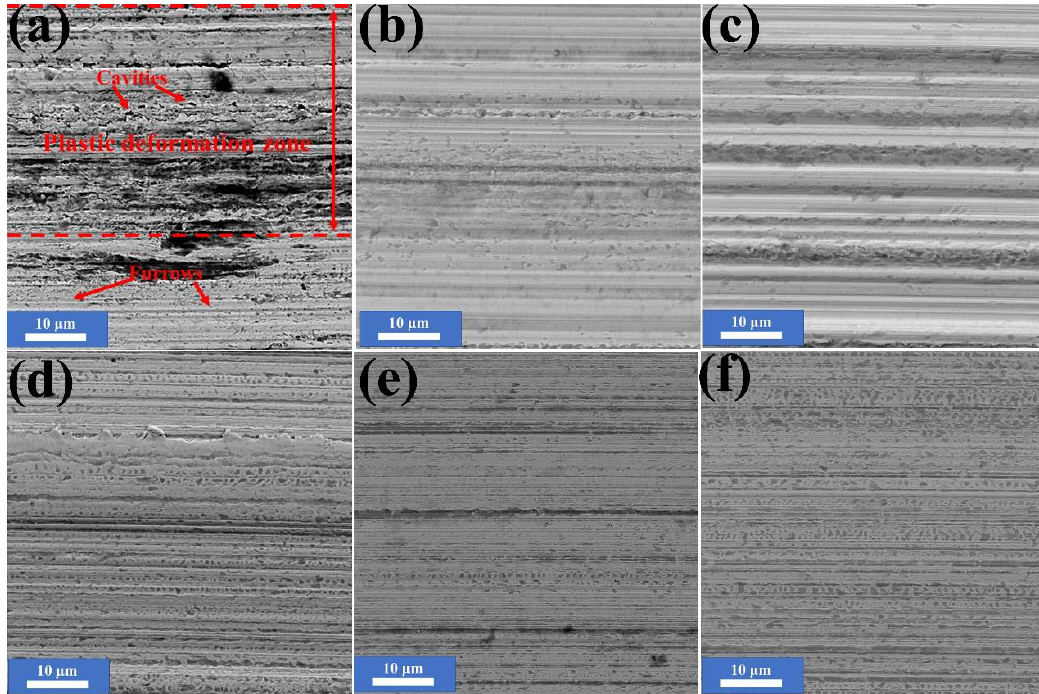
Figure 8. SEM morphologies of worn surface of friction pairs under the lubrication of pure LP (( a ) 1 h, ( b ) 2 h, and ( c ) 5 h), and LP+0.5 wt % NSPs (( d ) 2 h, ( e ) 3 h, and ( f ) 5 h) after different sliding times. ( b ) 2 h, and ( c ) 5 h), and LP + 0.5 wt % NSPs (( d ) 2 h, ( e ) 3 h, and ( f ) 5 h) after di ff erent sliding